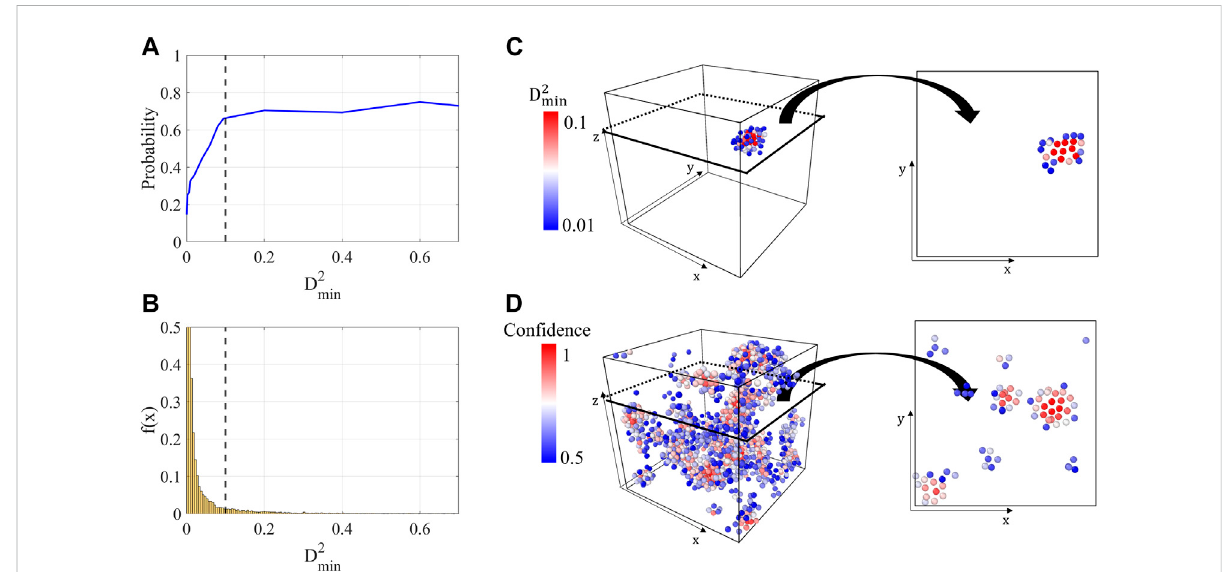
FIGURE 3 Correlation between non-af fi ne displacement and the probability that the model classi fi es atoms of speci fi c non-af fi ne displacements as STZ: (A) the x -axis is the non-af fi ne displacement of atoms and the y -axis is the probability (ratio) that the trained model classi fi es atoms with a corresponding non-af fi ne displacement value as STZ atoms. (B) Histogram of non-af fi ne displacement values (normalized as the probability density function). (C) The fi gure on the left is the true STZ atoms and the corresponding non-af fi ne displacement values. A cross-section view at a constant z value is displayed in 2D in the fi gure on the right. (D) The fi gure on the left shows the predicted STZ atoms and the probability that the model predicted them as STZ atoms (i.e., con fi dence). Also, the cross-section view at the same z value in (C) is displayed in 2D on the